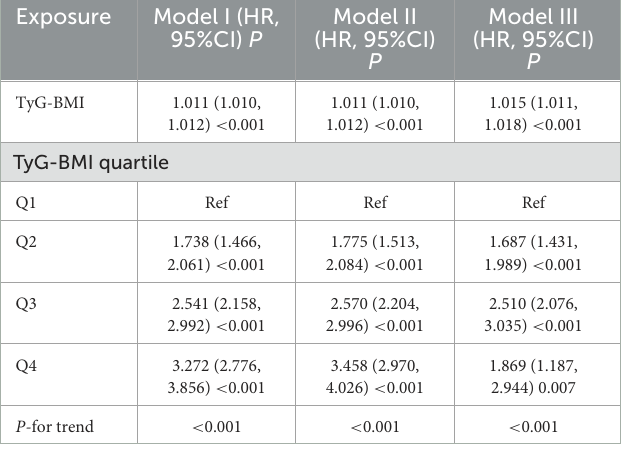
TABLE 5 Relationship between TyG-BMI and the risk of diabetes in participants with prediabetes in different sensitivity analyses. Exposure